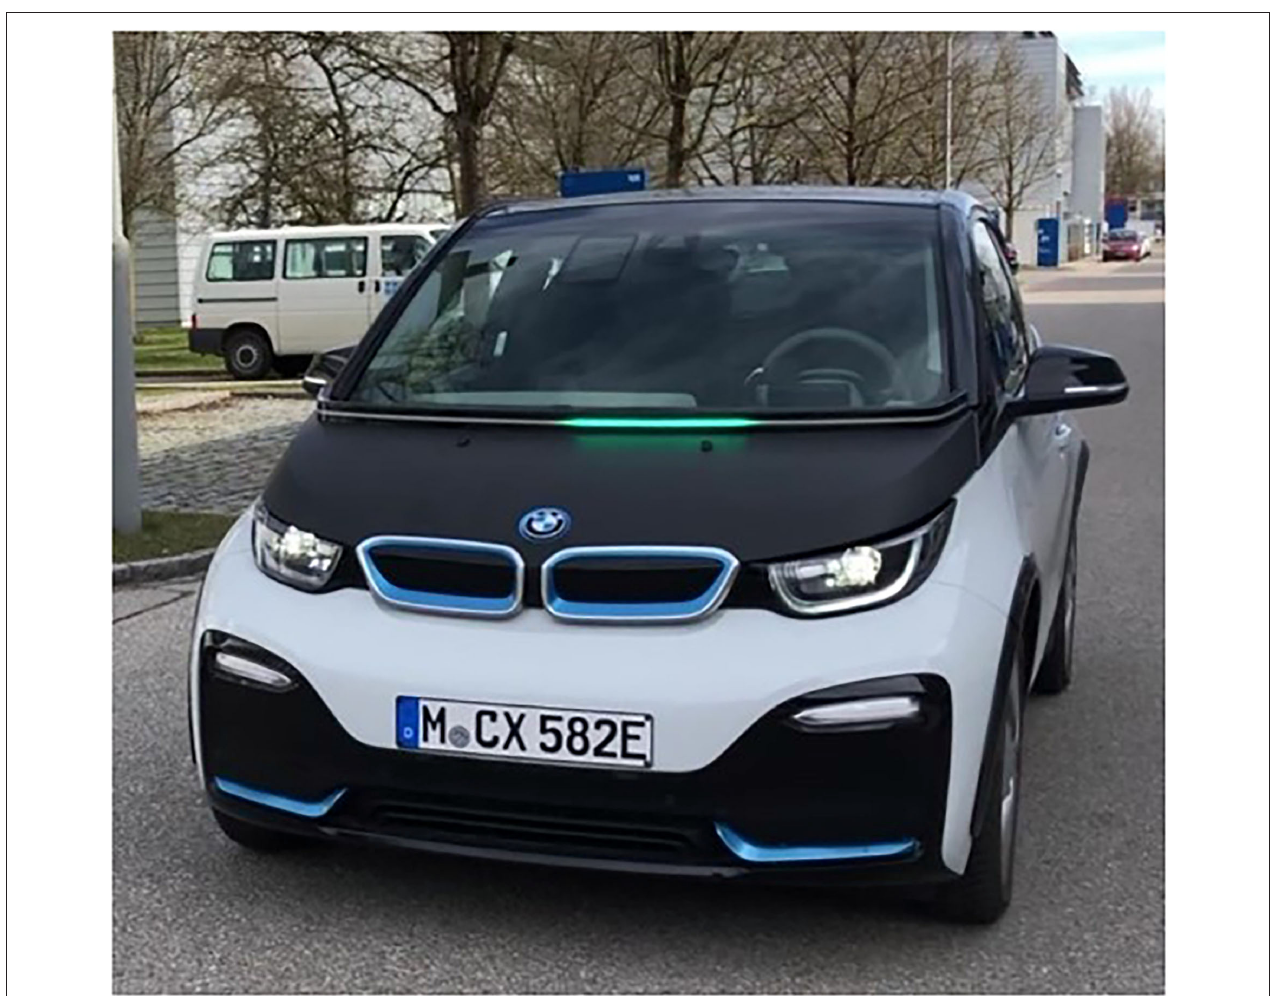
FIGURE 3 | eHMI concept perception-based light-band that communicates “I saw you” following the